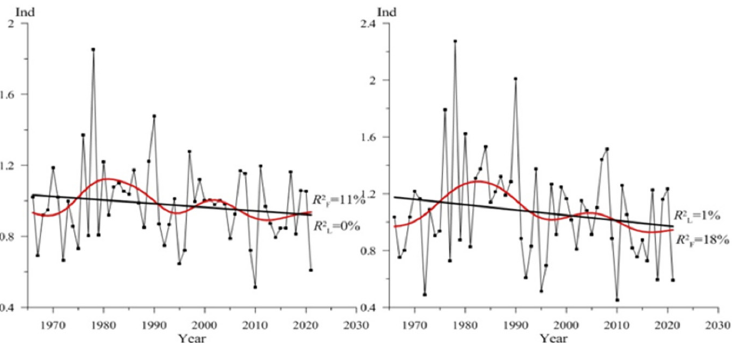
Figure 7. Long-term changes of Sapozhnikova’s Humidity Coefficient (left) and Selyaninov’s Hy- drothermal Coefficient (right) in Kazan (see Figures 1 and 2).